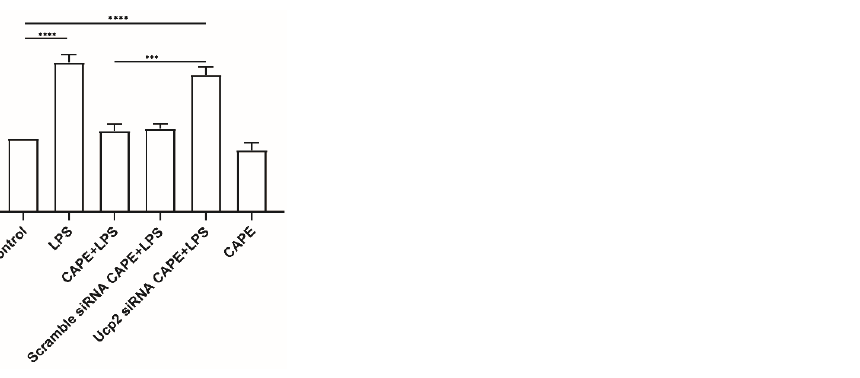
Figure 6. Effect of UCP2 knockdown on ROS production in ARPE19 cells. ROS levels were determined by Mitosox red fluorescence. The mean fluorescence intensities (MFI) were analyzed by flow cytometry software (FlowJo). (n = 3 *** p < 0.001, **** p <0.0001). Adapted from Reference [60].